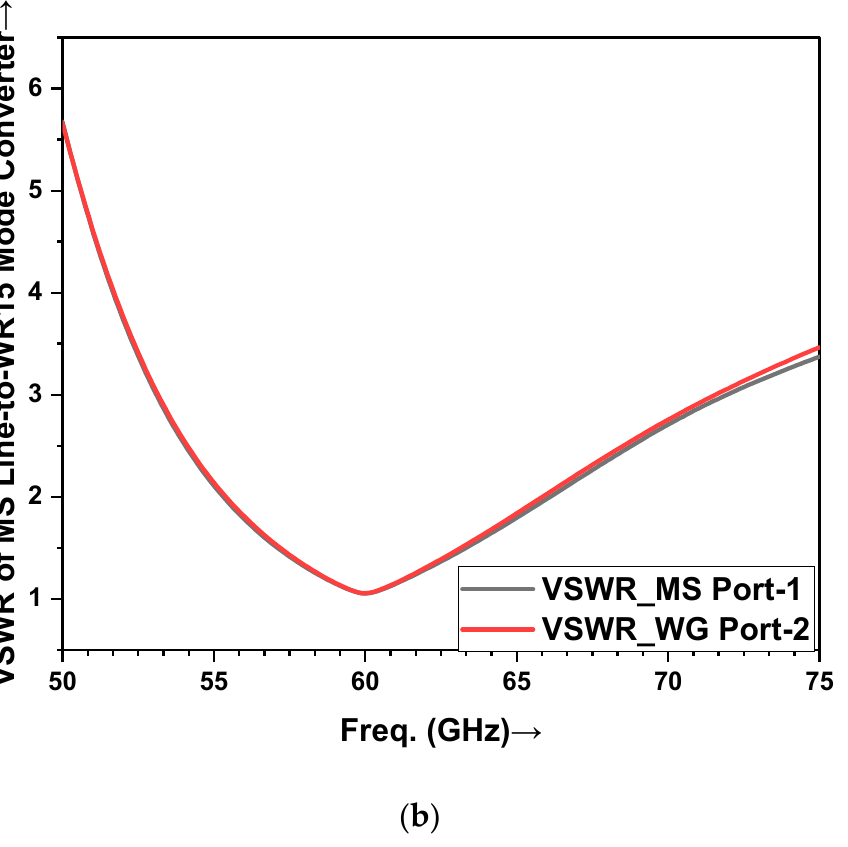
Figure 9. ( a ) Electric field mode conversion in the V-band inline MS line-to-WR-15 transition and ( b ) their VSWR plots.